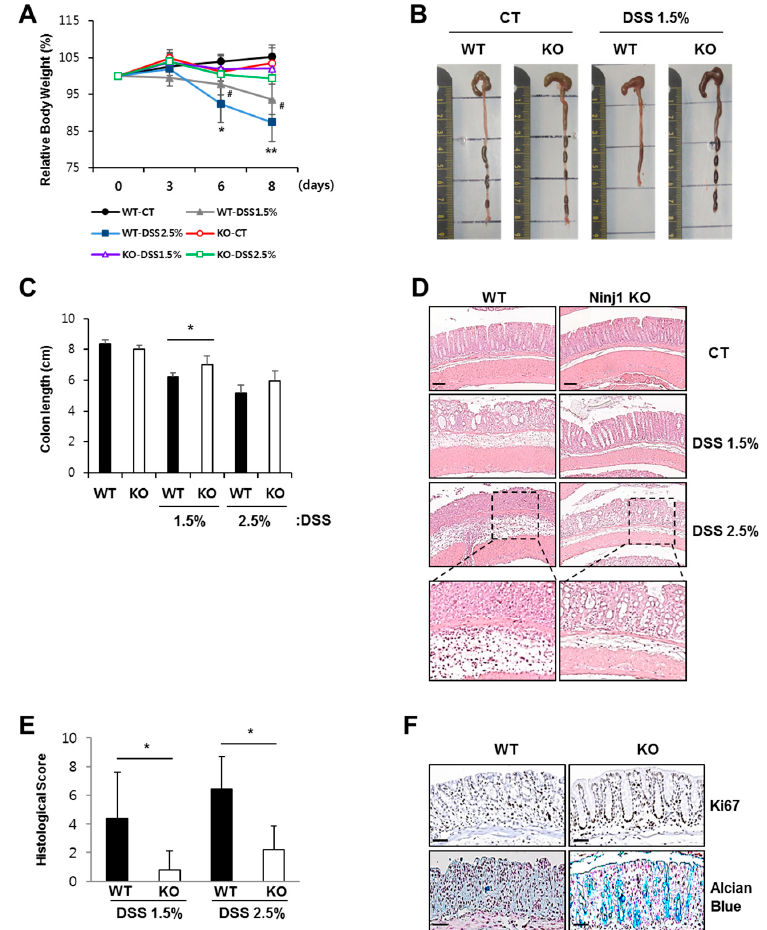
Figure 2. Ninj1 deficiency alleviates the development of intestinal inflammation. ( A ) WT and